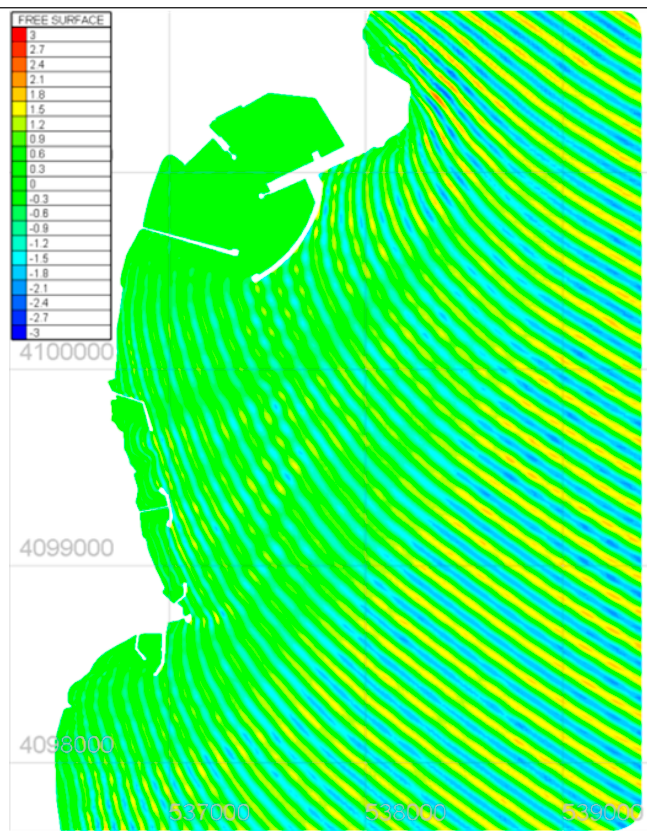
Figure 6. Example of a pattern of sea surface elevation resulting from the regular wave mode of TELEMAC–ARTEMIS, Case